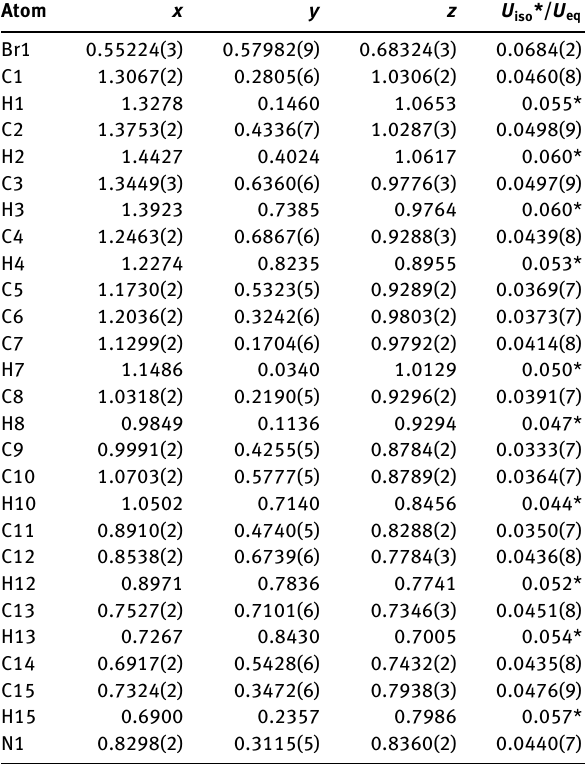
Table 2: Fractional atomic coordinates and isotropic or equivalent isotropic displacement parameters (Å 2